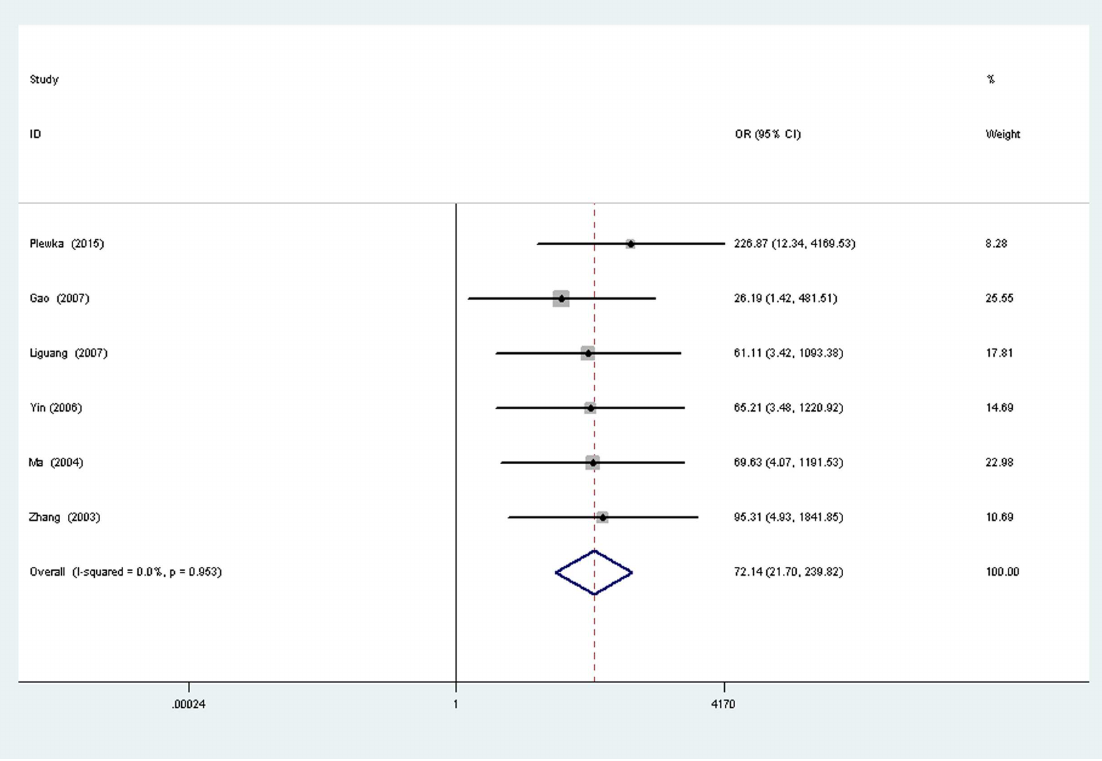
Fig 2. Forest plot depiction of survivin expression and odds ratio (OR) for ovarian carcinoma vs normal ovarian tissues.